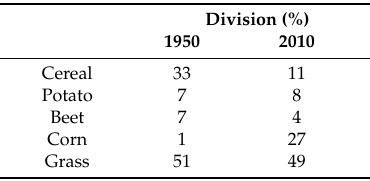
Table 3. Annual harvest ( Y ) in metric ton (1000 kg) product per ha, excluding straw and foliage. Cereal, potato, sugar beet, and fodder beet in ton fresh matter; corn and grass in ton dry